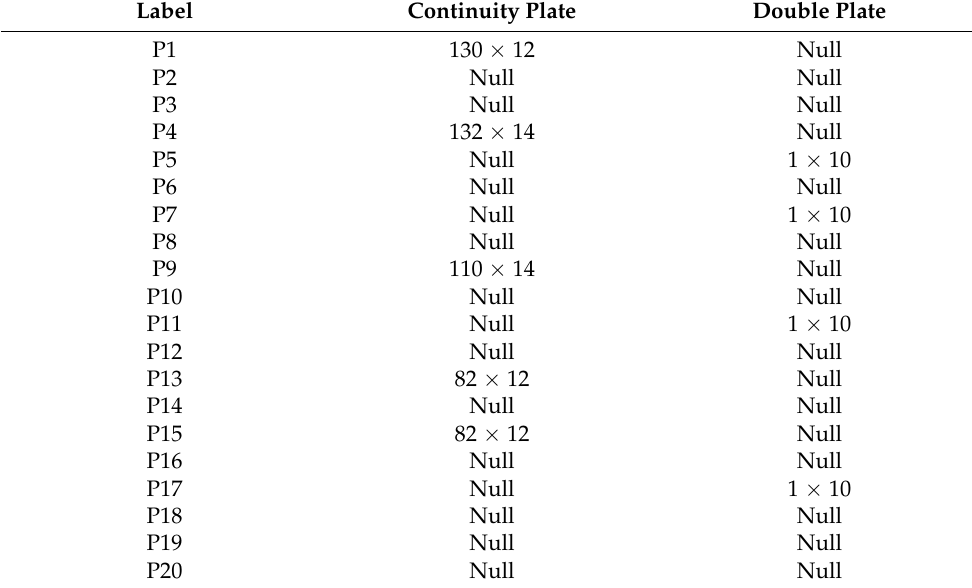
Table 9. Final web panel details (size in mm).